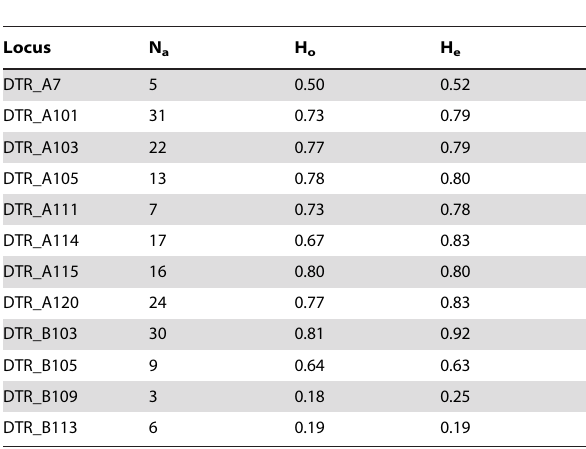
Table 1. Dascyllus trimaculatus microsatellite characteristics based on recruits (N =181, this